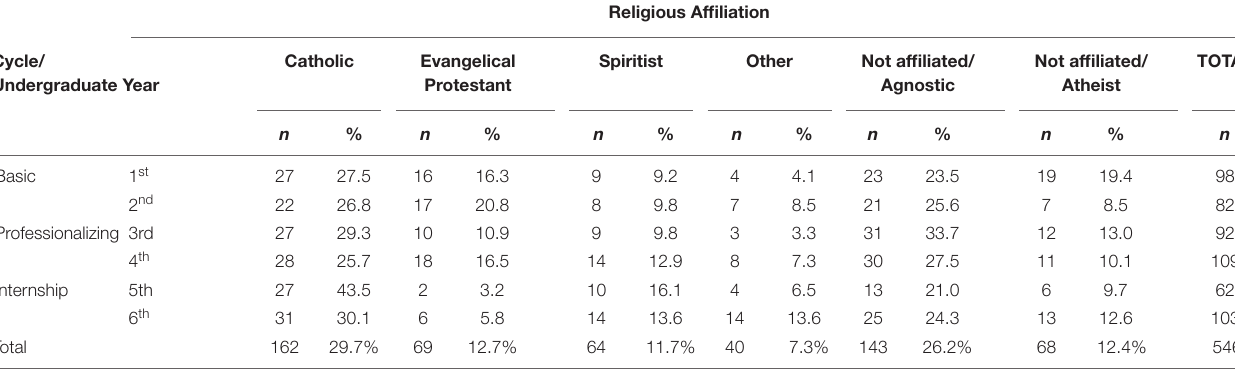
TABLE 2 | Organizational Religiosity per undergraduate year.